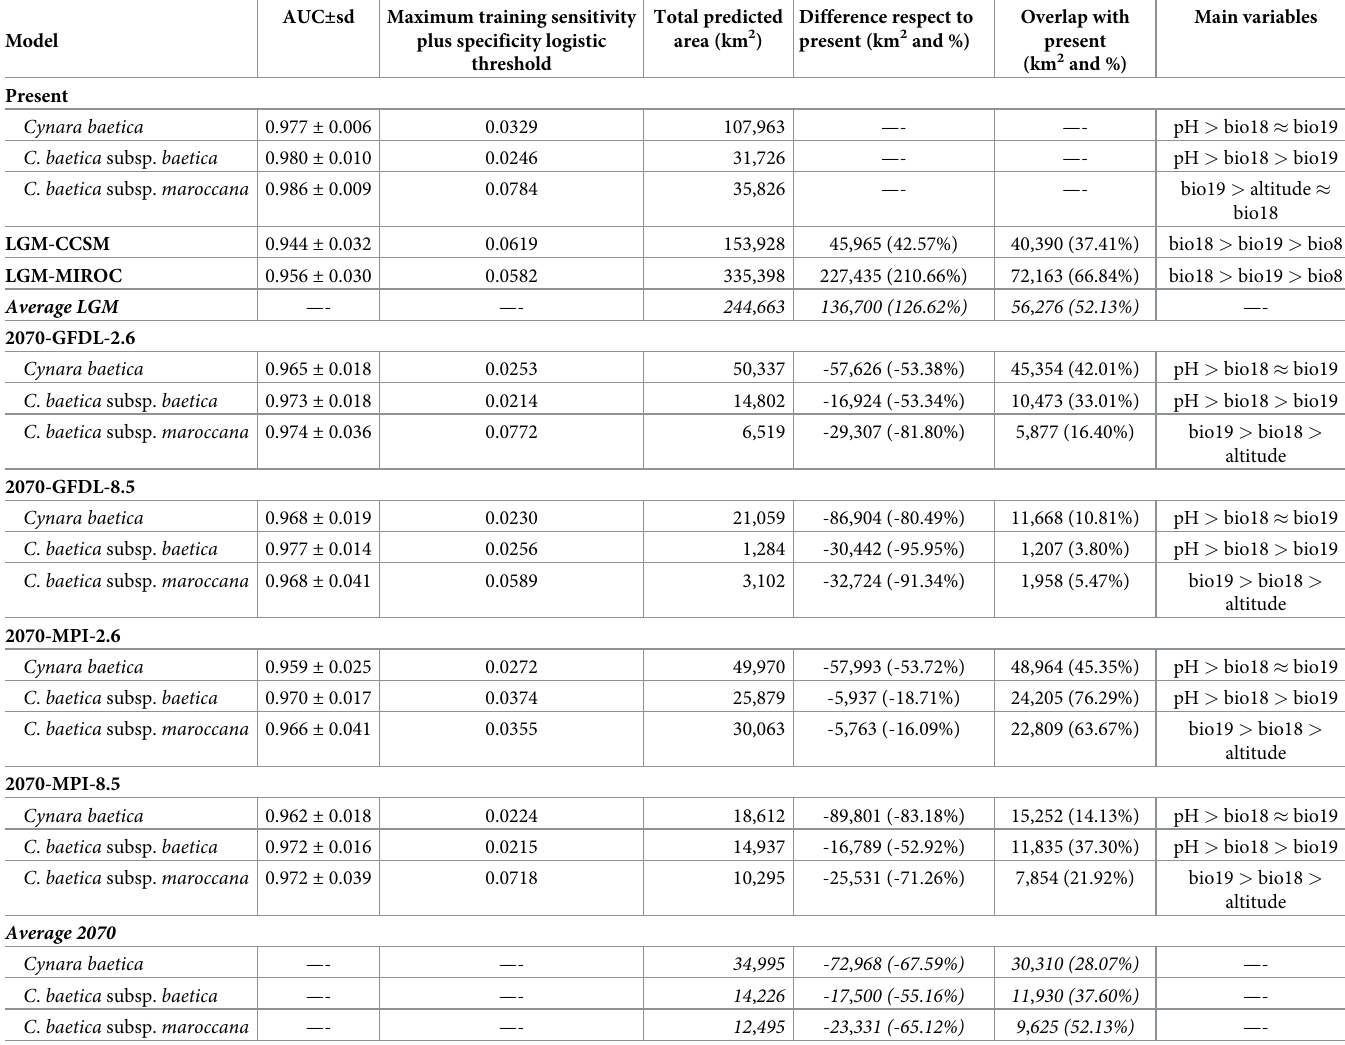
Table 4. Predicted potential distribution of Cynara baetica , with model performance details. The three most important variables for each model are included. Model